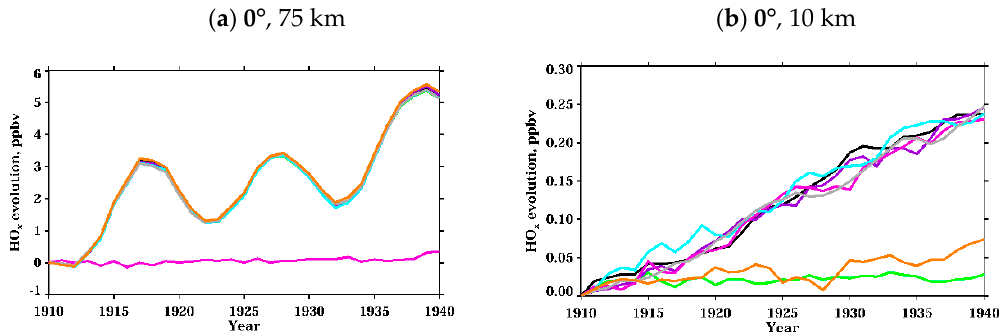
Figure 2. The time evolution of annual and zonal mean HO x since 1910. ( a ) In the tropical upper mesosphere panel; and ( b ) in the equatorial middle troposphere panel. The lines are black for ALL, violet for noEPP, magenta for fixUV, light blue for fixVIS / IR, green for fixGHG, orange for fixWMGHG, and grey for noVOL experiments.